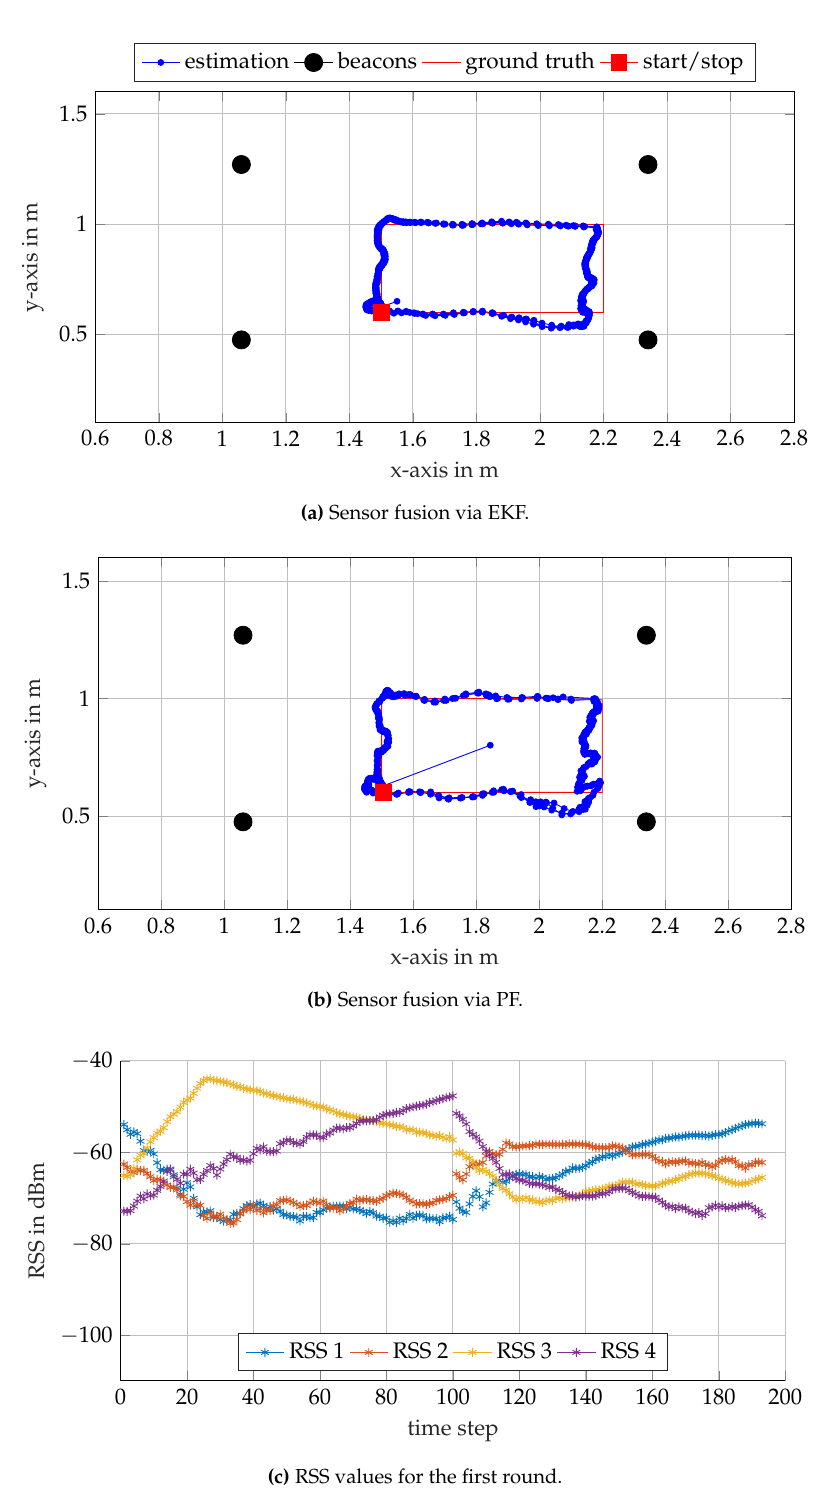
Figure 18. Self-localization results along a rectangular trajectory within the convex hull of the beacons. The receiver traverses the rectangle three times.